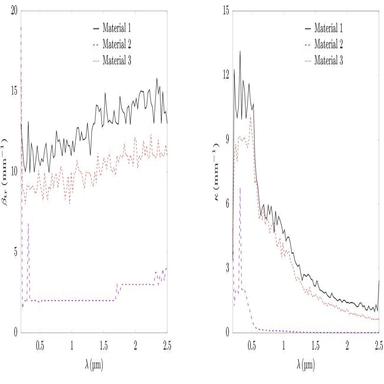
Transport extinction coefficient of materials 1–3. Fig. 12. Absorption coefficient of materials 1–3.